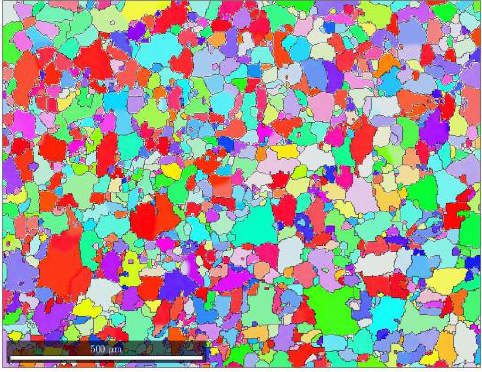
Figure 1. EBSD morphology of as-received aluminium alloy 7075. Table 1. Main chemical composition (in wt%) of aluminium alloy 7075.